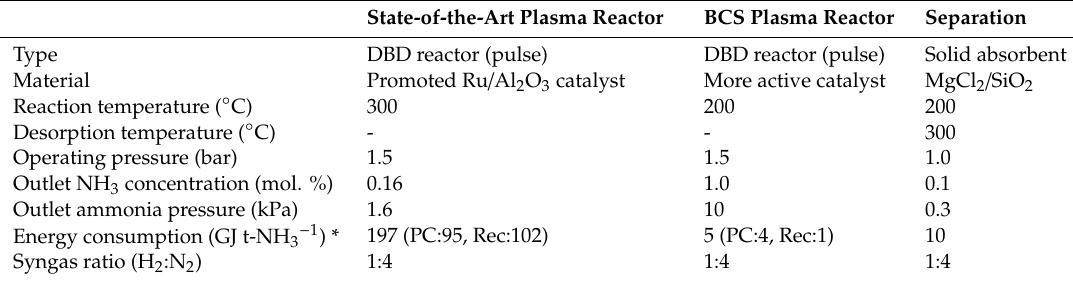
Table 3. Synergy between plasma and ammonia separation and storage. * This includes the energy consumption for plasma-catalytic ammonia synthesis (PC) and the energy consumption for recycling (Rec). The energy consumption for recycling is based on the outlet NH 3 concentration, based on interpolation of estimates in [16,67]. The state-of-the-art value for plasma catalysis is based on the data of Kim et al. [43], while the best-case scenario is based on an energy input of 0.7 eV due to a decrease in the N 2 dissociation barrier over Ru catalysts (see Section 2.2) [38]. The di ff erence between the operating pressure of the plasma reactor and the separation step is to account for the pressure drop over the system.